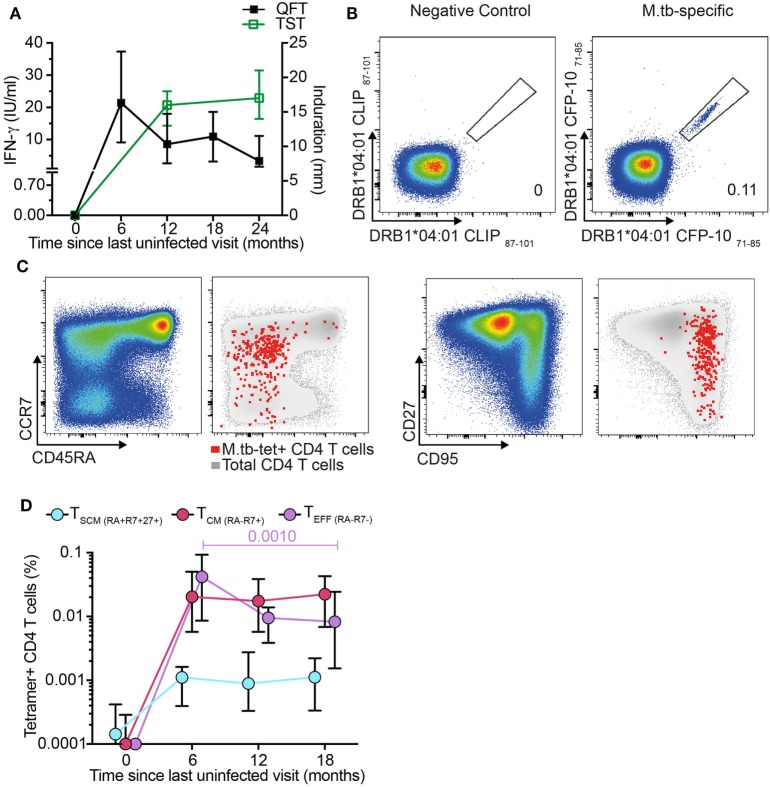
Mycobacterium tuberculosis (M. tb)-specific TSCM are detected in recently M. tb-infected adolescents. (A) Median (error bars denote IQR) of Tuberculin Skin Test (TST) and QuantiFERON-TB Gold In-Tube (QFT) performed at the indicated time points. A 5 mm and 0.35 IU/ml cutoff were used to define positive TST and QFT, respectively (n = 19 participants). (B) Representative flow cytometry plots showing peripheral blood mononuclear cells staining with two identical major histocompatibility complex (MHC) class II tetramers conjugated to PE and APC to detect CD4+ T cells specific for CFP-10. Tetramers matched by MHC allele but loaded with a self-peptide were used as negative control. Number indicates percentage of tetramer+ CD4 T cells. (C) Representative flow cytometry plots for memory markers CD45RA, CCR7, CD27, and CD95 gated on bulk (pseudo-color and gray) and M. tb-specific CD4+ T cells (red dots). (D) Median (error bars denote IQR) frequencies of M. tb-specific TSCM (CD45RA+ CCR7+ CD27+, light blue), TCM (CD45RA− CCR7+, magenta), and TEFF (CD45RA− CCR7−, purple) during primary M. tb infection (n = 12 participants).